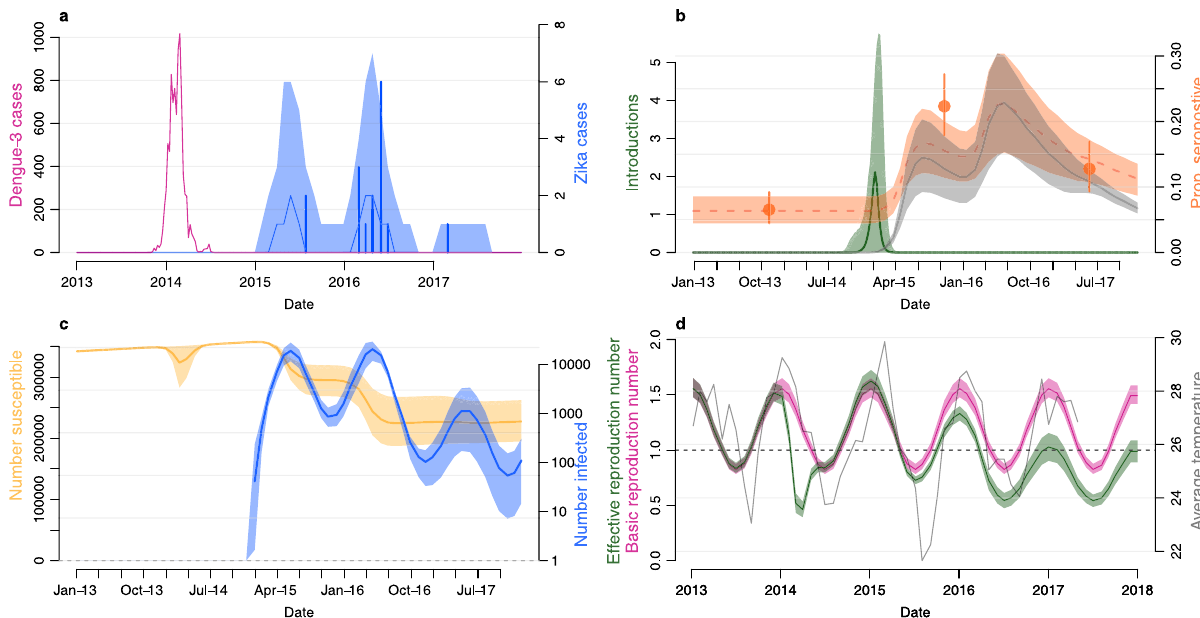
Fig. 2 Estimated transmission of ZIKV in Fiji using a mathematical model and multiple data sources. a Pink line, weekly cases of DENV-3. Blue bars, monthly cases of ZIKV. Blue dashed line and region, model estimated median cases of ZIKV and 95% CrI. b Seroprevalence and introduction of ZIKV. Green line and region, estimated median introduction of ZIKV infected individuals and 95% CrI. Grey line and region, estimated median proportion of the population that had recovered and were temporarily immune to ZIKV infection (median and 95% CrI). Orange dashed line and region, estimated observed seroprevalence and 95% CrI. Seroprevalence includes an estimated 6.3% (95% CrI: 4.4--8.5%) false positive rate and 79% (95% CrI: 52--98%) assay sensitivity. Orange dots and vertical lines, observed ZIKV seroprevalence from three serological surveys (mean and 95% binomial CI, n = 458, 327, 321 in 2013, 2015, 2017, respectively). c ZIKV infection dynamics in Central Division. Yellow line and region, median and 95% CrI of the number of people susceptible to ZIKV. Blue line and region, median and 95% CrI of the number infected on the natural log scale. d Pink line and region, estimated basic reproduction number for ZIKV (median and 95% CrI). Green line and region, effective reproduction number (median and 95% CrI). This included an estimated decline in transmission coinciding with a 2014 vector clean-up campaign 8 . Grey line, monthly temperature data from Suva, Central